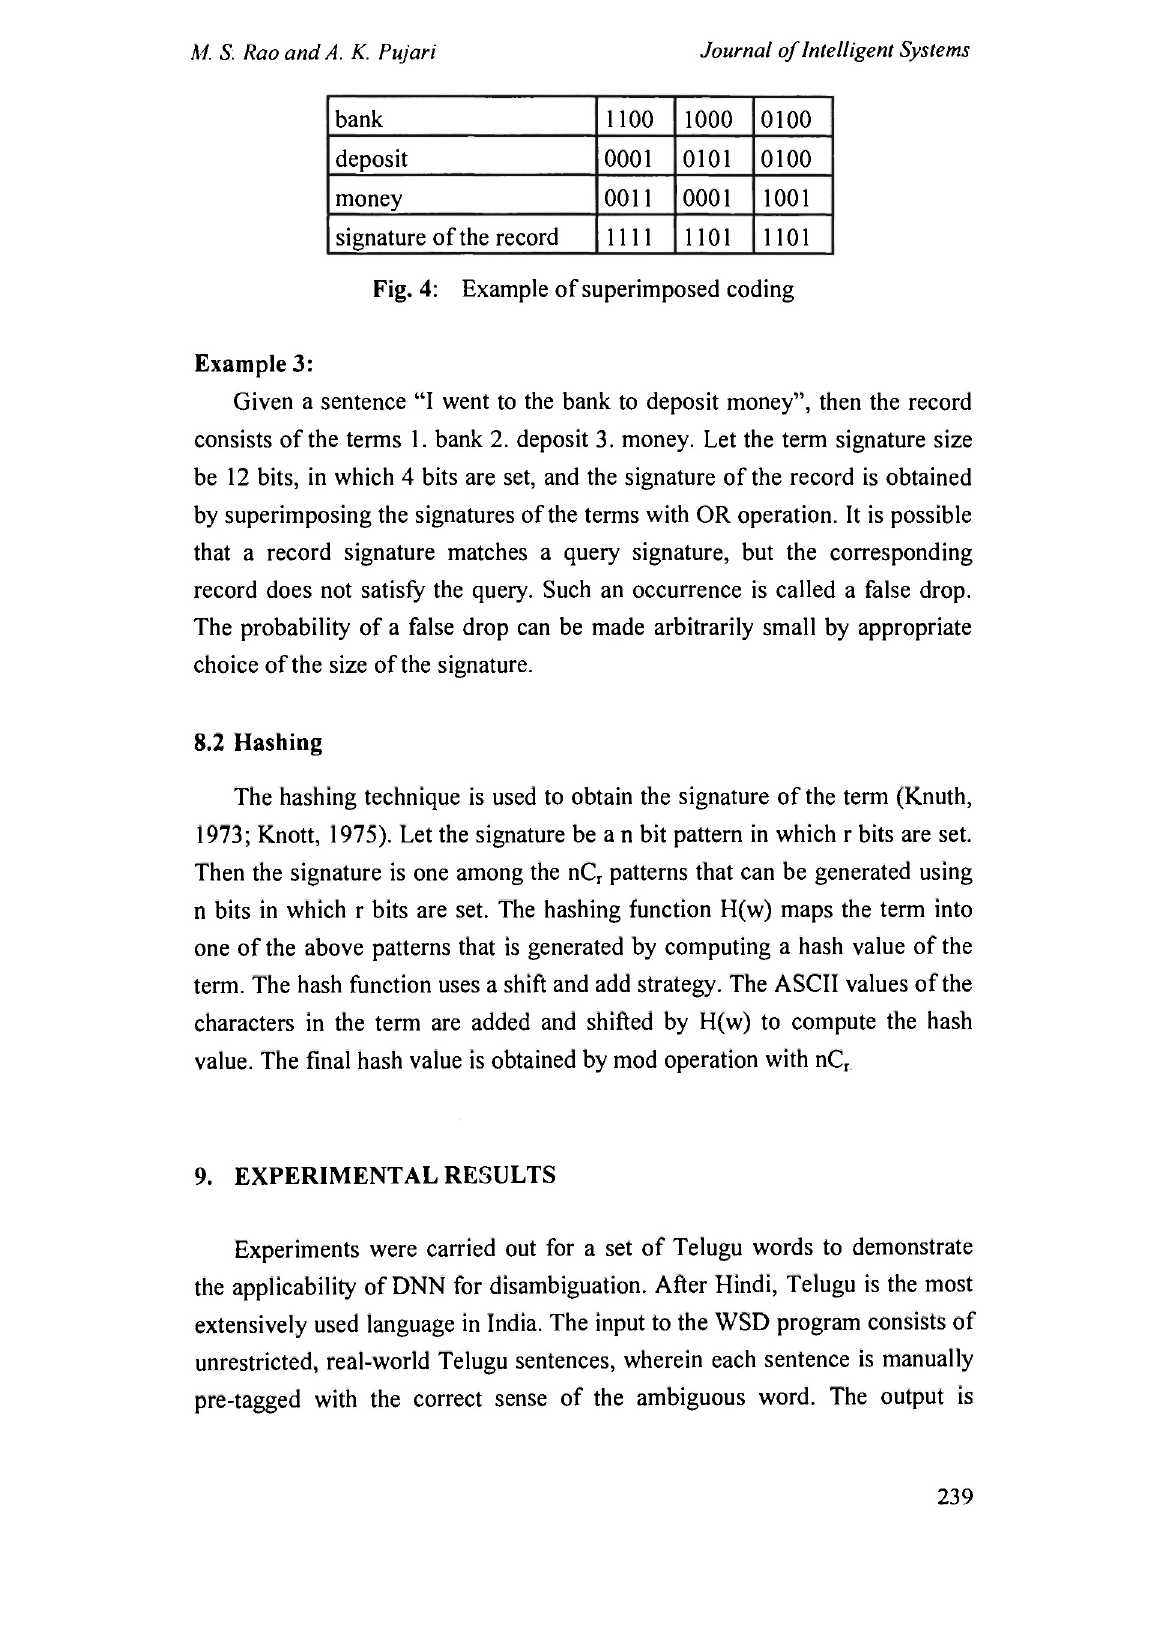
Fig. 4: Example of superimposed